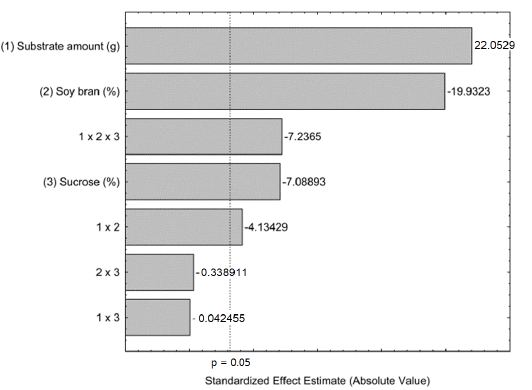
Figure 2. Pareto chart for effects of substrate amount, proportion of soy bran and sucrose concentration on the FFase production by A. tamarii Kita UCP 1279 using a mixture of wheat and soy bran as substrate through solid ‐ state cultivation at 30 °C during 72 h.